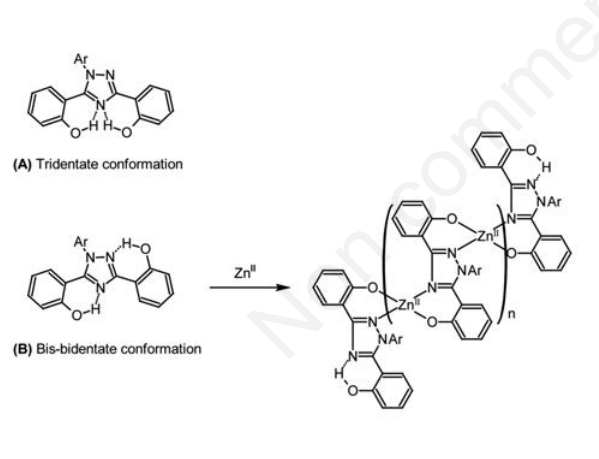
Figure 9. Two possible conformations of the triazole derivatives: (A) the tridentate conformation and (B) the bis-bidentate confor- mation. The bis-bidentate structure has a strong tendency to form polymeric complexes.